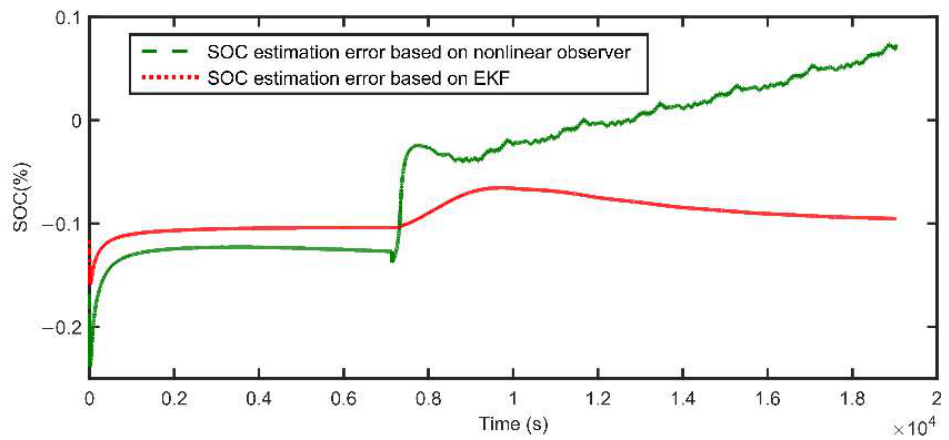
Figure 21. Comparison of SOC estimation error based on non-linear observer and EKF in dynamic condition test 2.